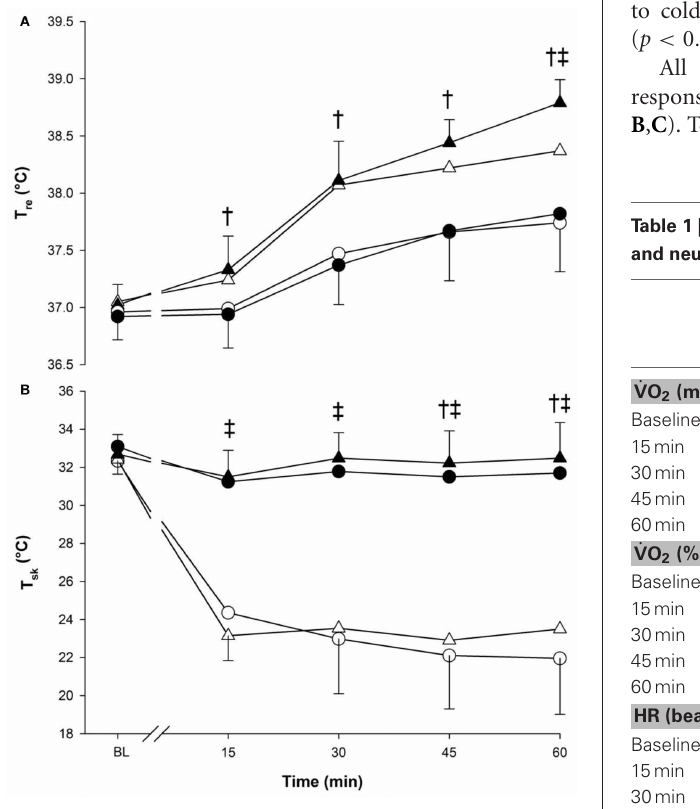
FIGURE 1 | Core (panel A) and skin (panel B) temperatures at baseline (BL) and during 60min of exercise during walking ( (cid:2) and • ) and running ( (cid:2) and (cid:2) ), in cold ( (cid:2) and (cid:2) ), and neutral ( • and (cid:2) ) ambient temperatures. Mean ( ± SD). † Significant difference between walking and running ( P < 0 . 05). ‡ Significant difference between cold and neutral ( P < 0 . 001).